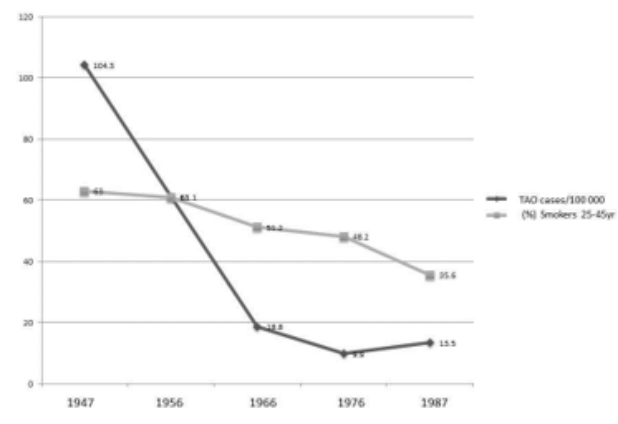
Figure 1. Numbers of recorded TAO cases per 100,000 patients in the Mayo Clinic in 1947, 1956, 1966, 1977, and 1987, and the prevalence rates of smokers between 25 and 45 years of age in the United States in the same